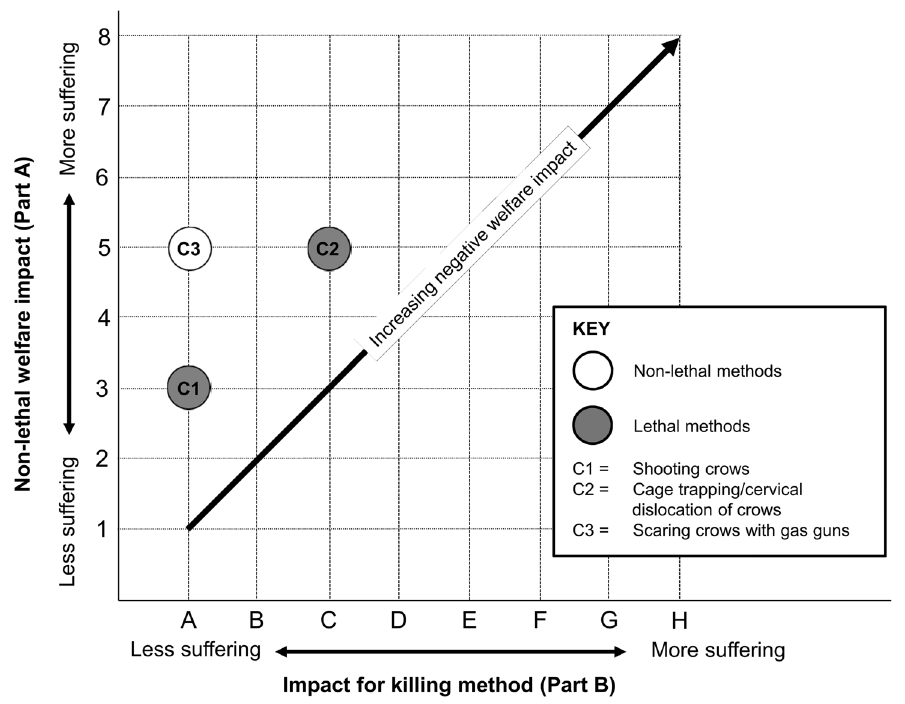
Fig 3. Welfare assessment grid for crow management